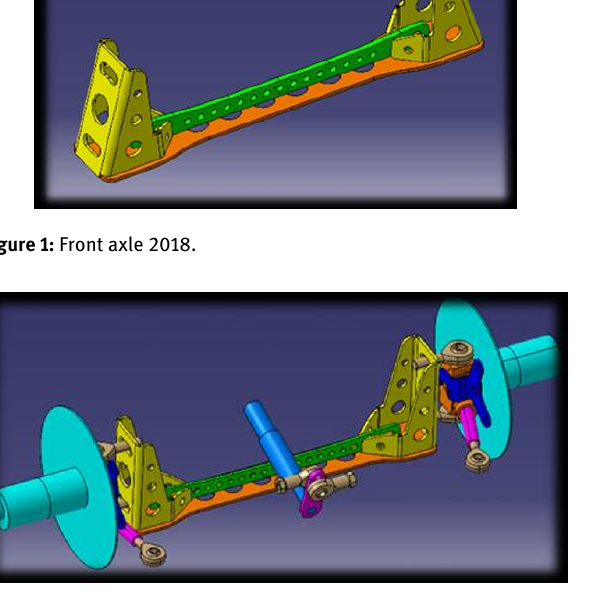
Figure 2: Front axle 2018. Table 1: Characteristics of aluminium 5754.